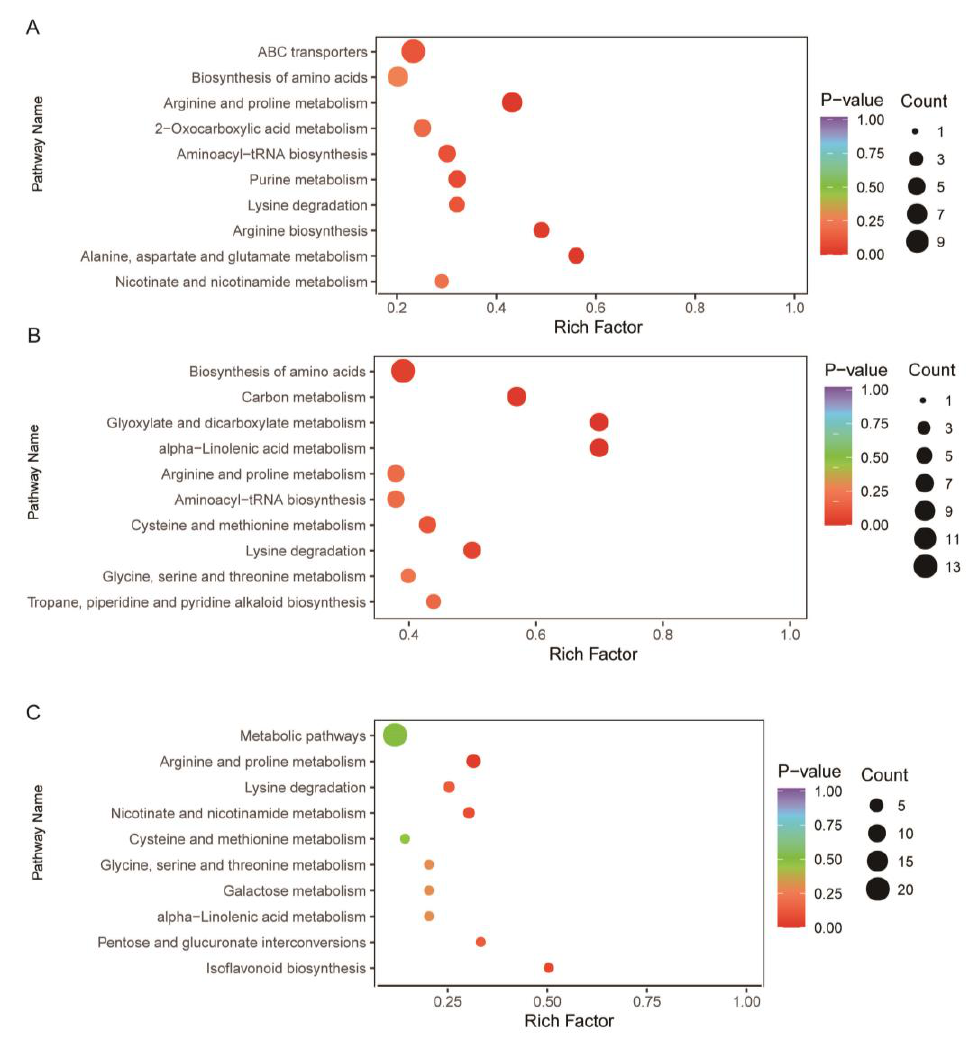
Figure 4. KEGG pathway enrichment analysis of DAMs in BBL/ZH58 ( A ), BFL-1/ZH58 ( B ), and BFL-